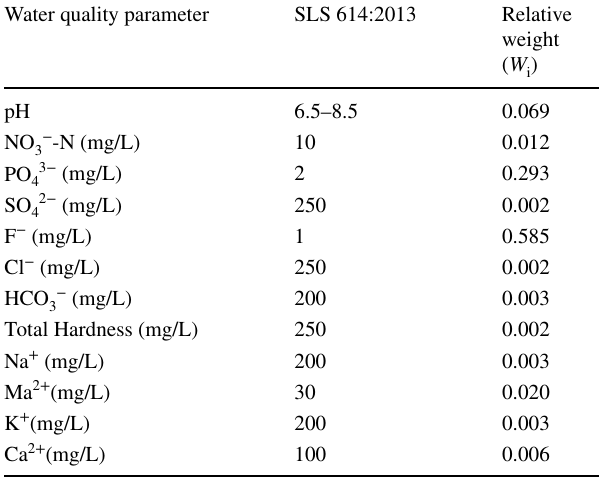
Table 1 Summary table of the calculated weights ( w weights ( W i ) and recommended SLS 614:2013 limits of each